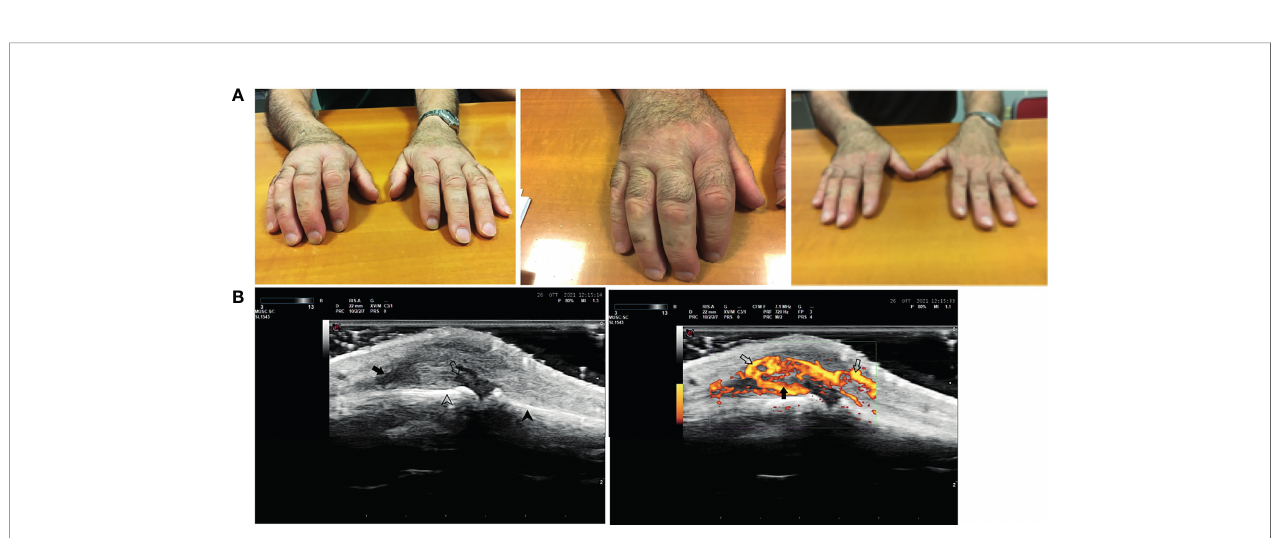
FIGURE 3 | Rheumatoid arthritis-like clinical presentation closely correlated with anti-SARS-2 vaccination. The fi gure shows a representative case of a rheumatoid arthritis-like clinical presentation in a patient after SARS-COV2 vaccination. Panel (A) From left to right: acute phase of the disease, a particular of the right hand, and clinical examination after 4 weeks of corticosteroid therapy. Panel (B) Ultrasound doppler examination of the 3rd metacarpal-phalangeal joint of the right hand (from left to right): Grayscale US, Joint capsule ( arrow ) of MCF III dilated by synovial proliferation ( open arrow ) grade III (gs) according to OMERACT criteria. Below are shown the surfaces of metacarpal bone (arrowhead) and proximal phalanx (open arrowhead); Power Doppler Same scan of Figure 1 with PD showing severly active synovitis ( arrow ) of grade III (pd) according to OMERACT criteria With PD signal becames evident an associated paratenonitis of third digit extensor tendons (open